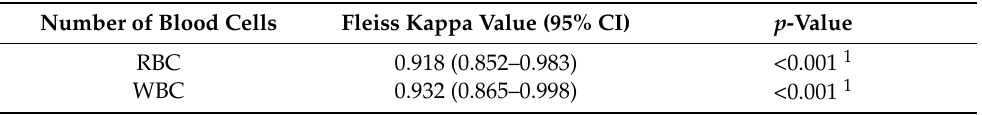
Table 3. Reliability of agreement (inter-rater reliability) of blood cell enumeration among the three independent technicians. Number of Blood